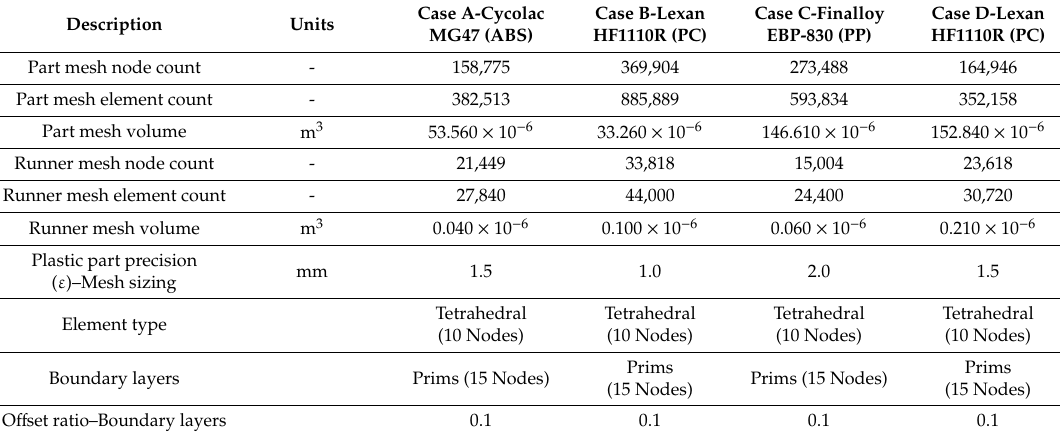
Table 7. Statistics of meshes defined for each plastic part analyzed numerically.